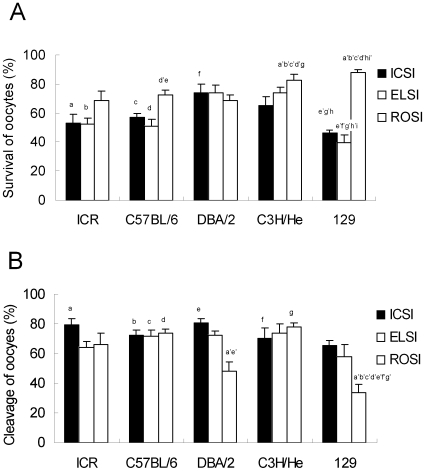
Effects of genotype and male germ cell type on oocyte survival (A) and cleavage to the 2-cell stage (B) following microinsemination.Data from fresh and frozen germ cells are combined and are expressed as the mean ± SEM. The combinations of characters from a-a′ to i-i′ indicate significant statistical differences (P<0.01) analyzed by multiple comparisons using the Tukey–Kramer procedure.